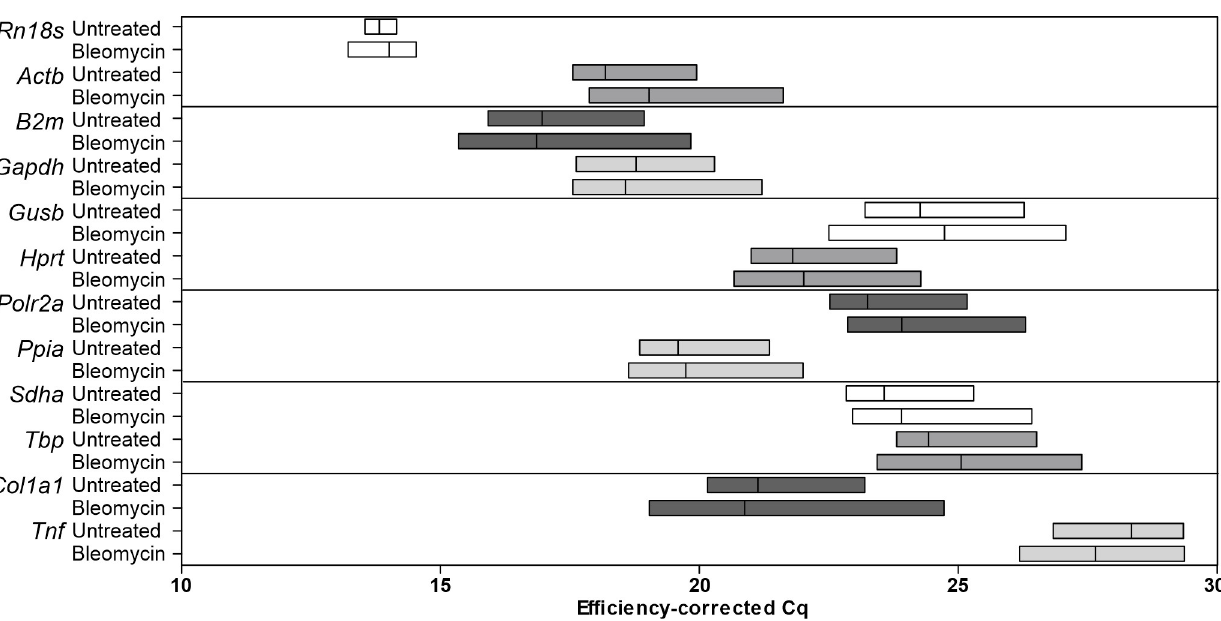
Fig 3. Efficiency-corrected Cq values for the genes investigated in untreated and bleomycin-treated mice. Untreated: untreated samples. Bleomycin: bleomycin-treated samples. Each box has lines for minimum, maximum and mean values. X-axis truncated; 40 cycles were run. n = 9–10.